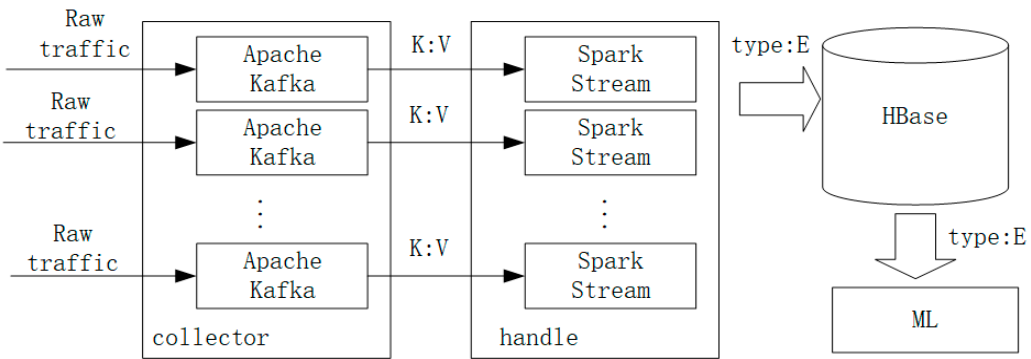
Figure 2. Feature processing flow.